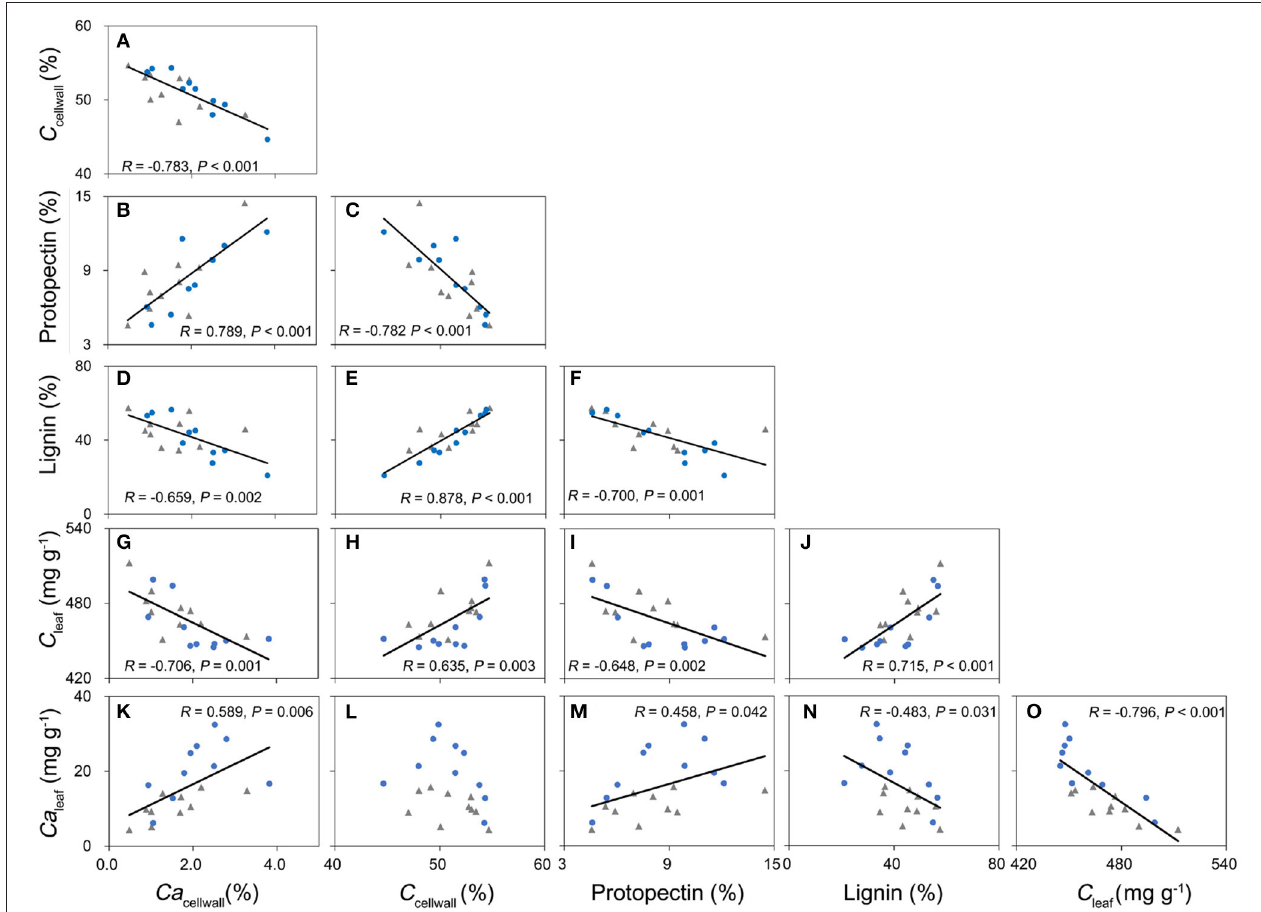
FIGURE 5 | The relationships among carbon in the leaf cell wall (C cellwall ), calcium in the leaf cell wall (Ca cellwall ), lignin, and protopectin in the leaf cell wall, leaf carbon concentration (C leaf ), and leaf calcium concentration (Ca leaf ) of 20 broad-leaved tree species (A–O) . R: Pearson’s correlation coefficients. Filled blue circles are ten species from the non-karst sampling site, and filled gray rhombs are ten species from the karst sampling site. Solid lines correspond to significant correlations for paired traits ( P ≤